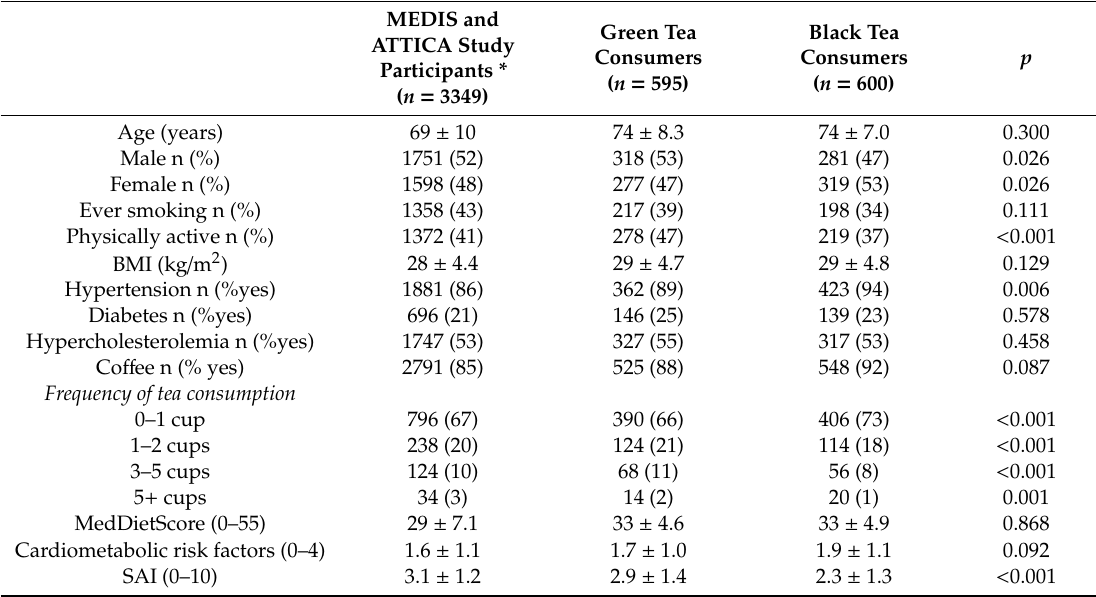
Table 1. Sociodemographic, lifestyle, and clinical characteristics of the ATTICA and MEDIS study participants based on the type of tea (green / black) they consume.